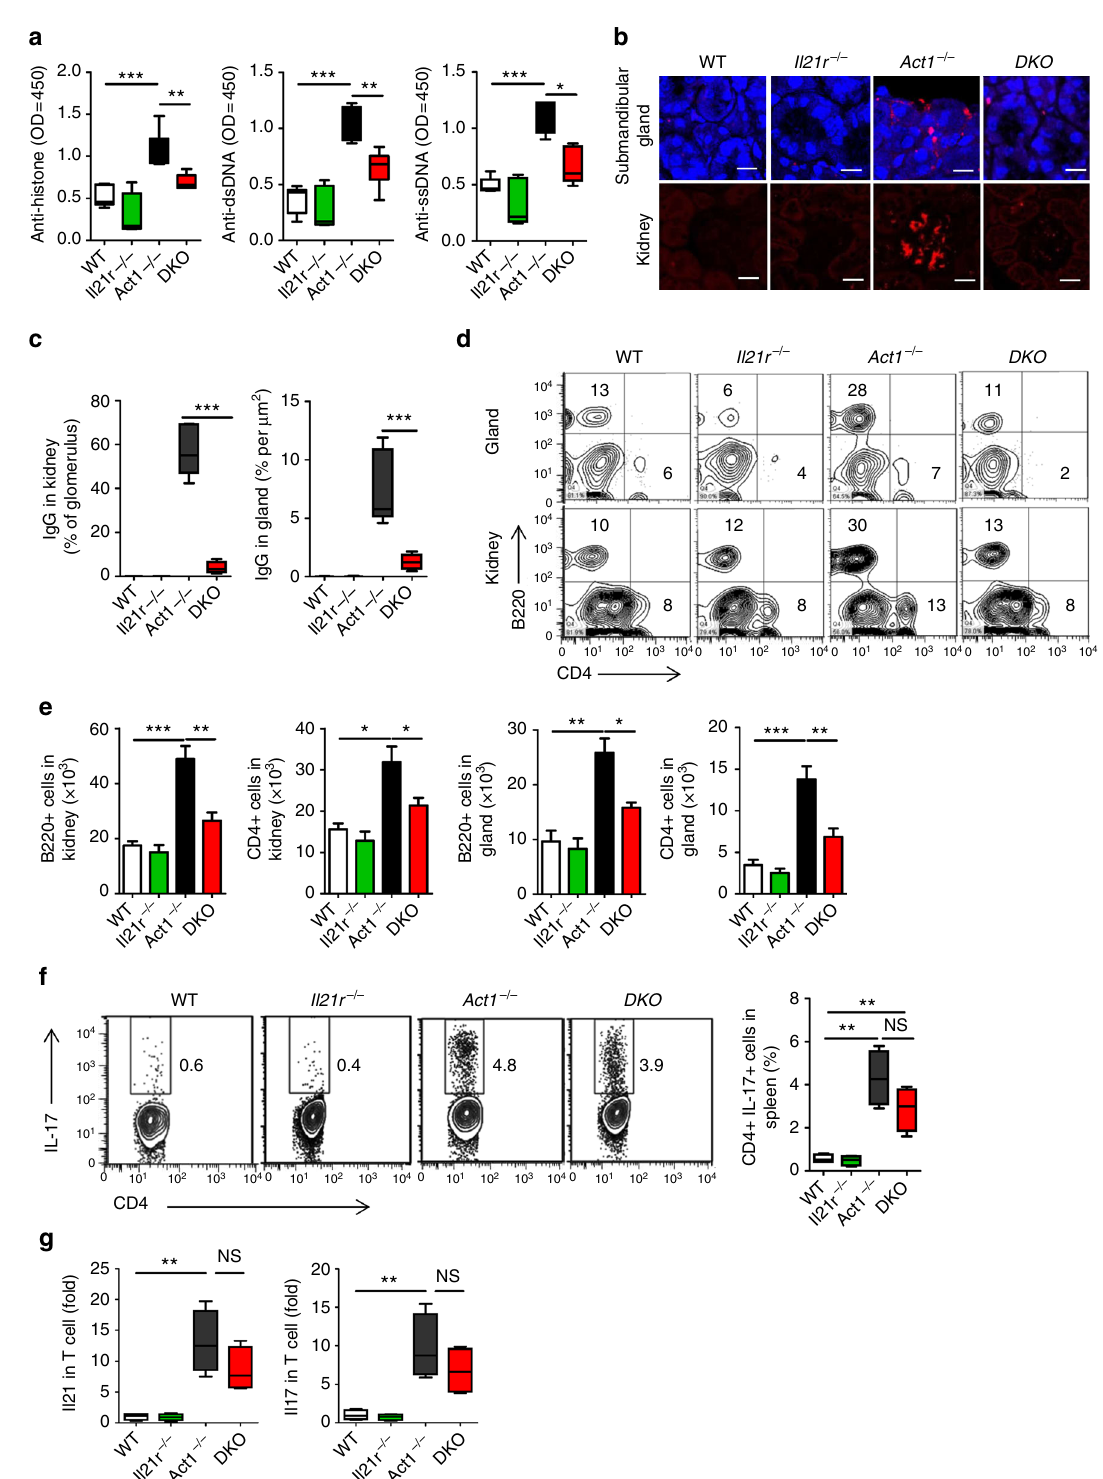
Fig. 5 IL-21R required for the autoimmune diseases in Act1 − / − mice. All the experiments were performed on C57B/L6J background 7-month-old wild-type, Act1 − / − , Il21r − / − , and Act1 − / − Il21r − / − mice housed in SPF facility. a Serum samples were obtained and analyzed for levels of anti-histone, anti-dsDNA, and anti-ssDNA lgG. b Kidneys and submandibular glands were harvested and quick frozen in OCT, followed by immuno fl uorescence staining for IgG (red). Scale bars, 50 µ m. c Quanti fi cation of lgG deposit in glomerulus of kidney and submandibular gland. d , e Flow cytometry analysis of CD45 + B220 + and CD45 + CD4 + cells from kidney and submandibular gland ( d ) and quanti fi cation of CD45 + B220 + cells and CD45 + CD4 + cells from submandibular gland and kidney ( e ). f Flow cytometry analysis of CD3 + CD4 + IL-17A + T cells from spleen. g RT-PCR analysis of IL-17 and IL-21 transcripts in CD4 T cells isolated from 8-month-old mice with indicated genotypes. N = 4 – 7/group. Mean± SEM. * p < 0.05, ** p < 0.01, *** p < 0.001. Two-tailed Student ’ s T test. All the data presented were from two independent